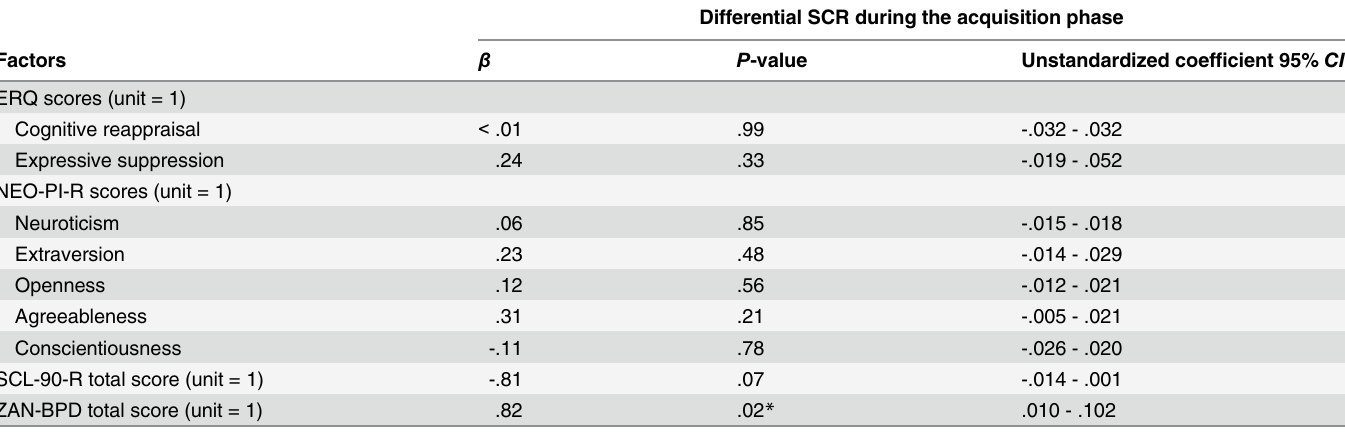
Table 2. Results of multiple linear regression analysis with differential SCR during the acquisition phase as a dependent variable in the interper- sonal stimulus condition.